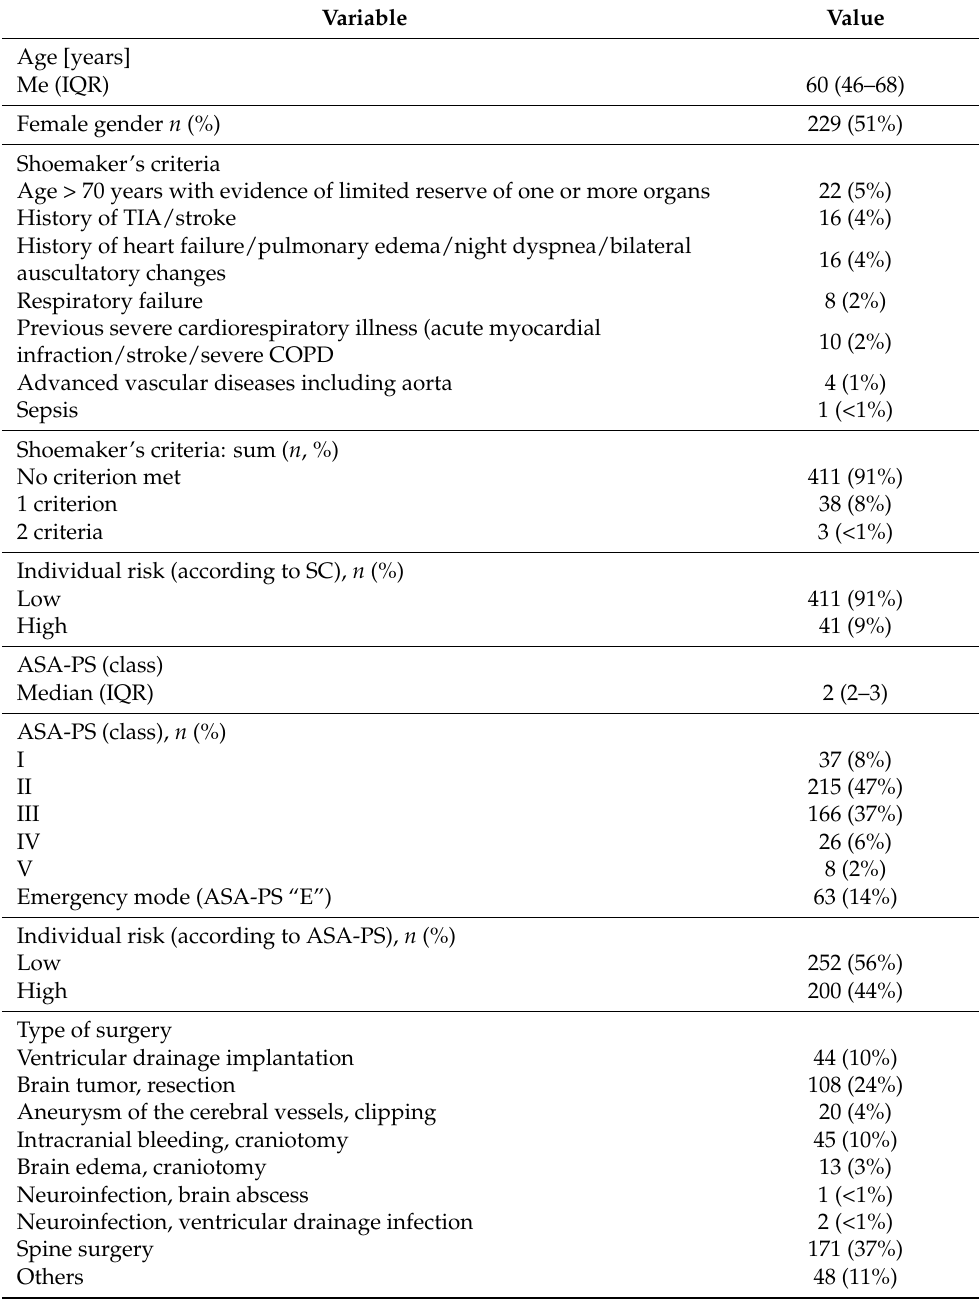
Table 1. Baseline demographic and clinical data for the study